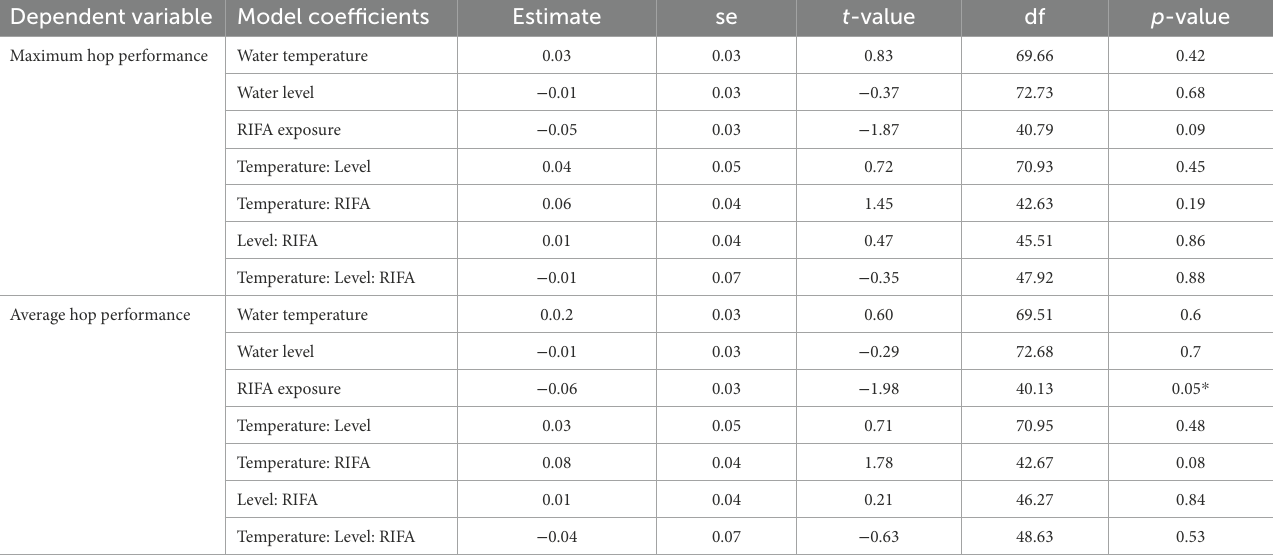
TABLE 3 Results of mixed-effects models for hop performance analysis for Incilius nebulifer toadlets.